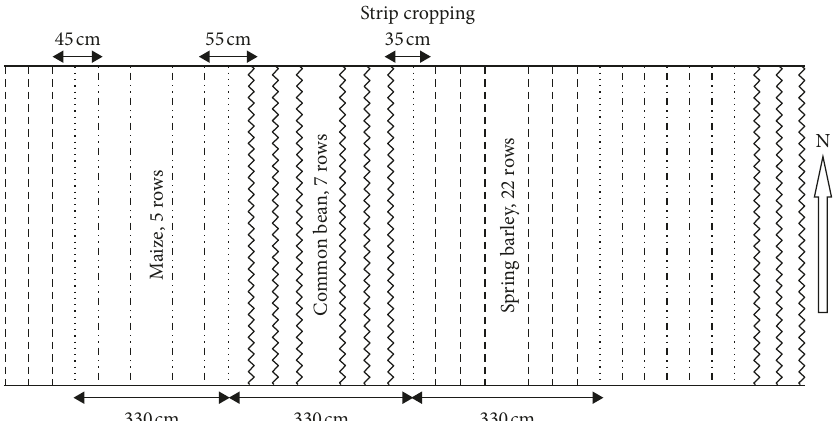
Figure 1: Row arrangements of maize, common bean, and spring barley in strip cropping. The row spacing of maize was 65cm, while that of common bean was 47cm, and that of spring barley was 15cm. N, Table 1: Rainfall and air temperature in months IV–IX as compared to the long-term means (1971–2005), according to the Meteorological Station in Zamo´s´c. Rainfall (mm), p